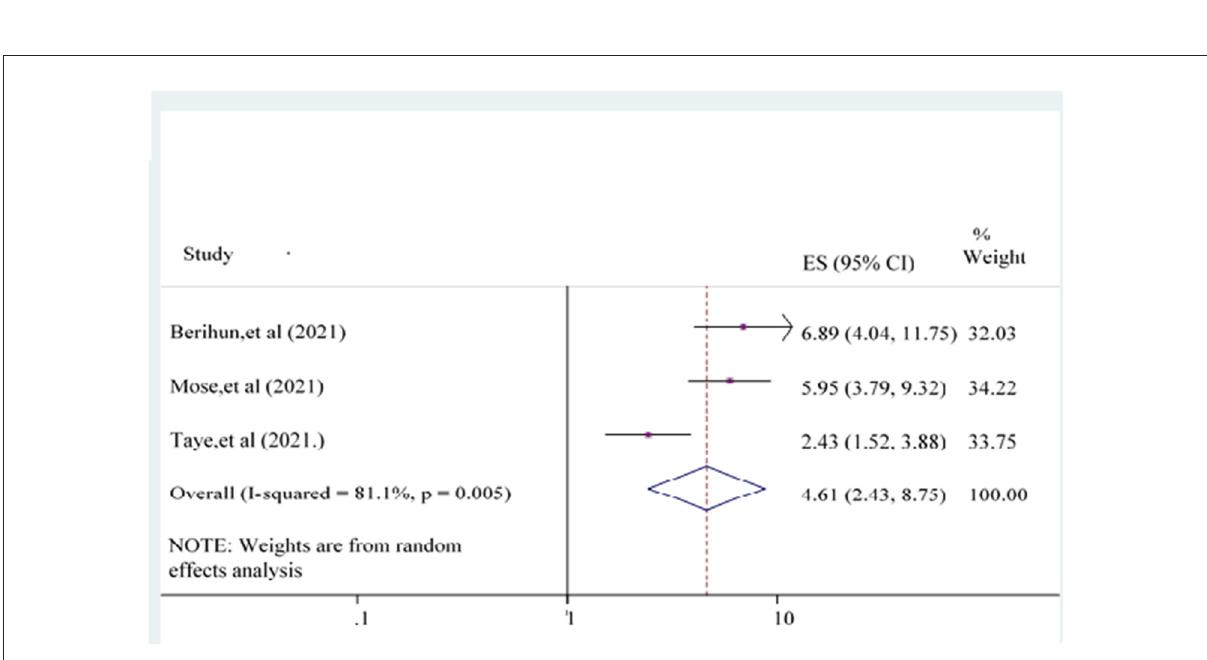
FIGURE8 Forest plot showing the relationship between knowledge and COVID-19 vaccine acceptance among the study